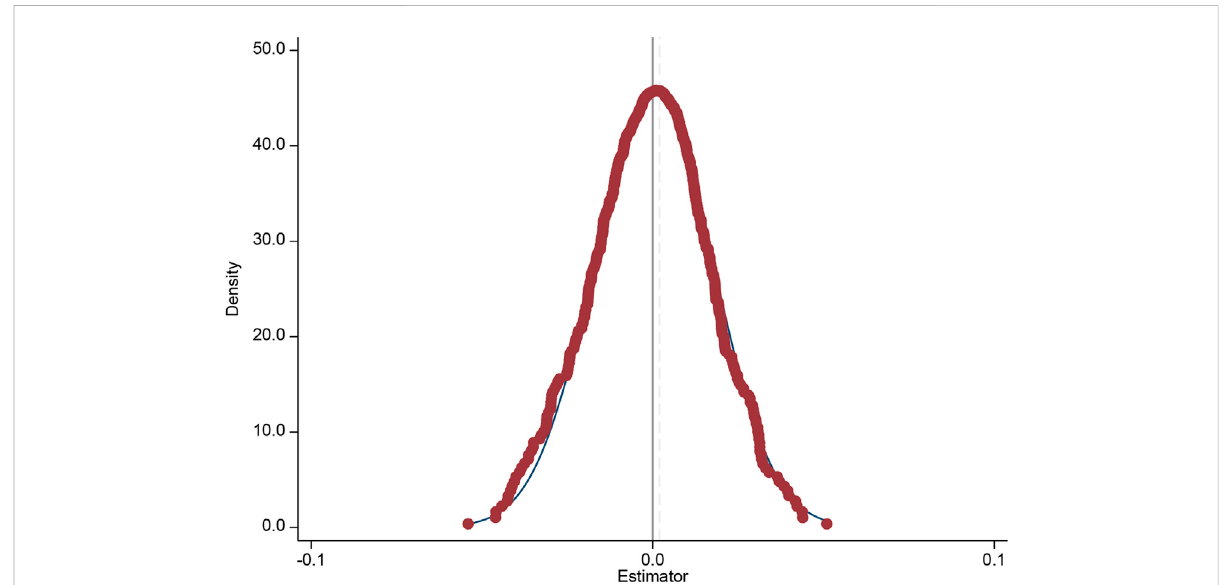
FIGURE 5 Results of placebo test. Treatment groups were randomly drawn 500 times in the control group by Monte Carlo simulation and DID regression was performed. Plot the obtained regression coef fi cients as a distribution graph. This fi gure reports the results of carbon emission performance of non-pilot cities as a dependent variable, presenting a normal distribution with an average value of